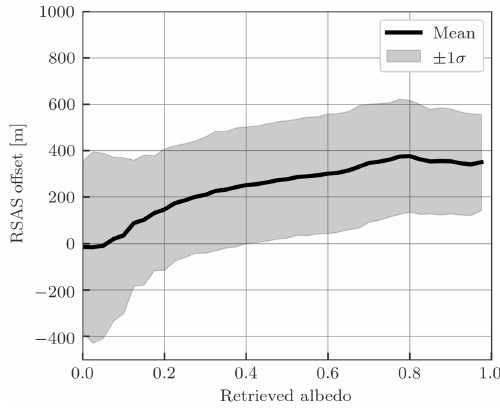
Figure 4. The dependence of the mean derived RSAS offset (and standard deviation) on retrieved effective surface reflectance over the same 2004–2010 time